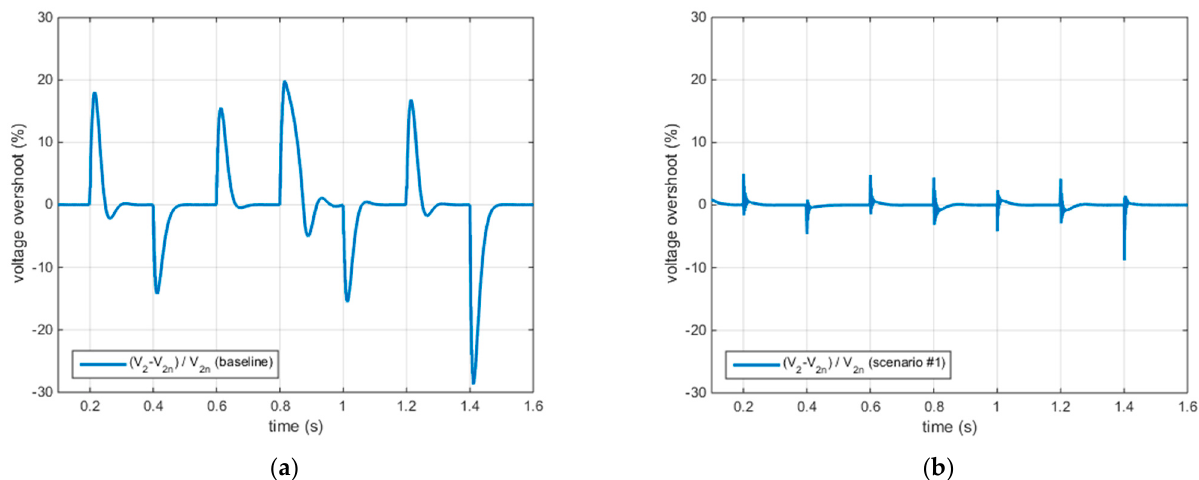
Figure 3. Grid voltage overshoot: ( a ) in baseline scenario; ( b ) in scenario #1 (SS − GN).